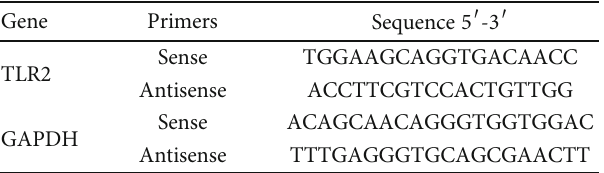
Table 1: Gene sequences for primer synthesis. Gene Primers Sequence 5 ′ -3 ′ Sense TGGAAGCAGGTGACAACC TLR2 Antisense ACCTTCGTCCACTGTTGG